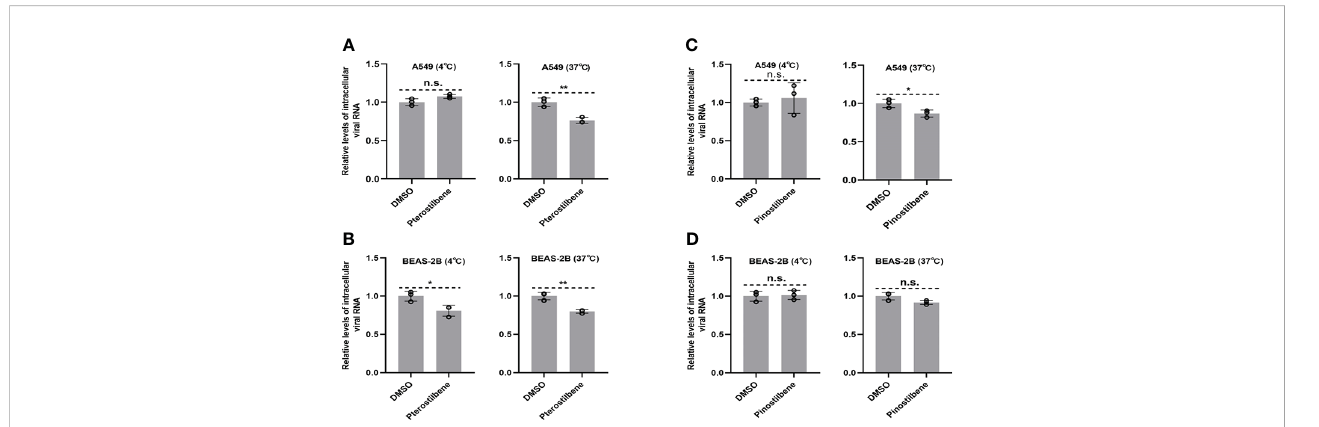
FIGURE 4 Pterostilbene (Pte) and pinostilbene (Pin) do not in fl uence EV-D68 attachment or entry into cells. (A – D) Cells were treated with Pte, Pin, or DMSO vehicle in 12-well plates under standard conditions. Cells were incubated at 4°C or 37°C for 30 min before infection and then incubated with EV-D68 viruses for 2 h. The qRT-PCR was performed to quantify viral RNA. EV-D68, Enterovirus D68; DMSO, dimethyl sulfoxide; qRT-PCR, quantitative reverse transcription polymerase chain reaction. Error bars indicate the standard deviation (n.s., no signi fi cance, *, P < 0.05; **, P <